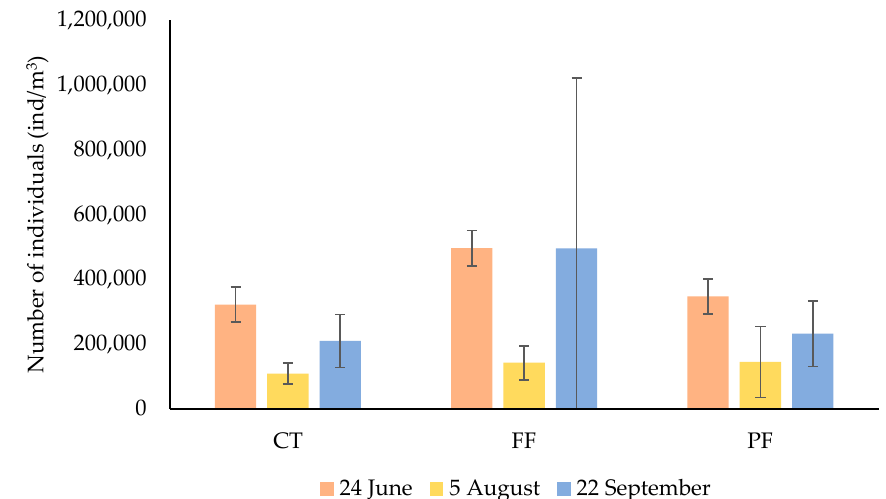
Figure 2. Average number of individuals of the zooplankton species per treatment at each sampling time; CT—Control; FF—Fishmeal-based feed; PF—Plant meal-based feed.